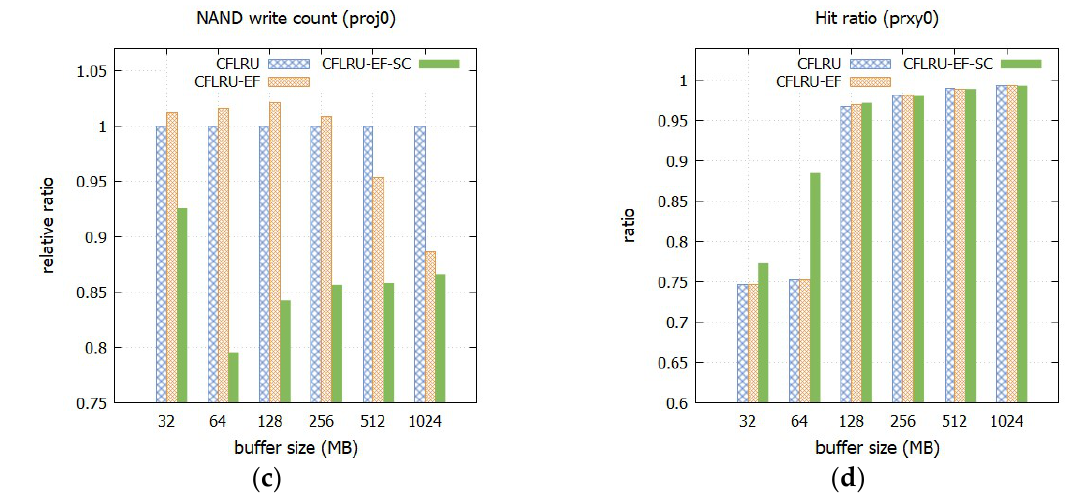
Figure 7. Cache hit ratio. ( a ) camresweba03-lvm01; ( b ) prn0; ( c ) proj0; ( d ) prxy0.